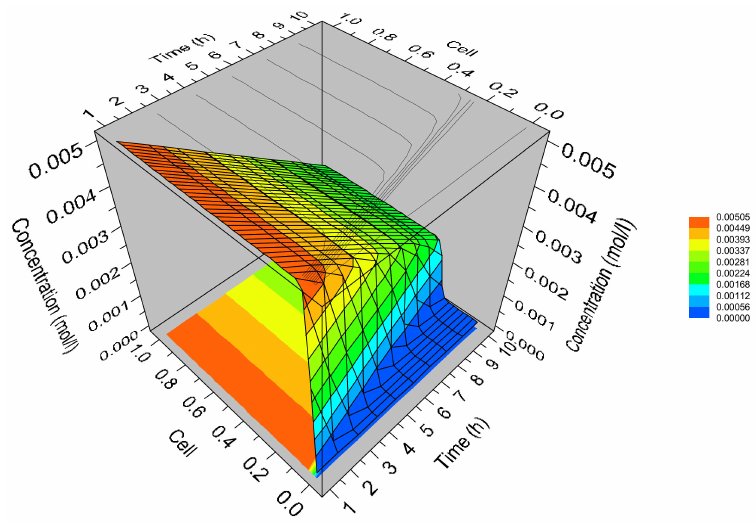
Figure 10. 3D concentration distribution of CO 2 in a discretization cell of the adsorption bed.